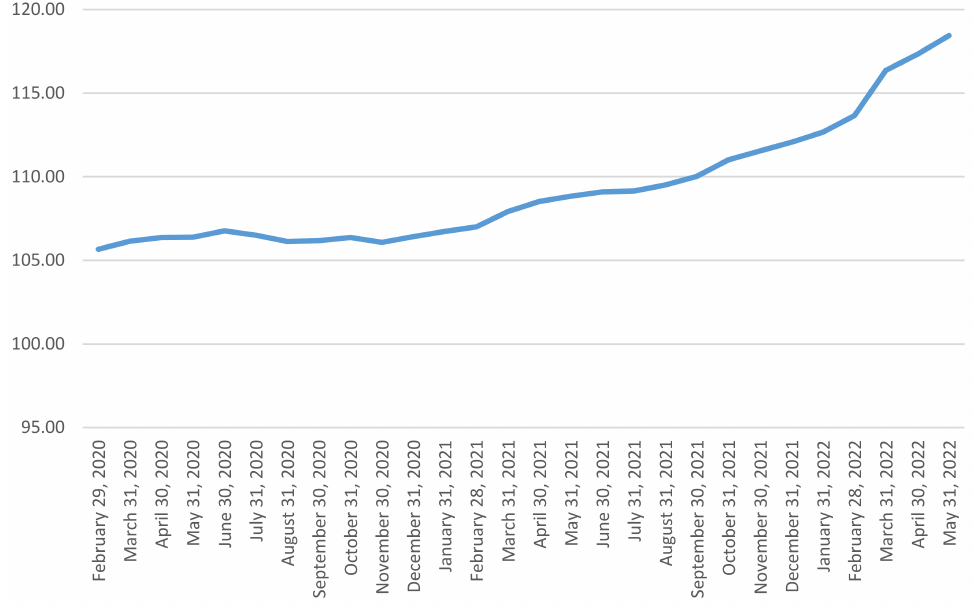
Figure 2. EU consumer price index, February 2020–May 2022, Source: according to